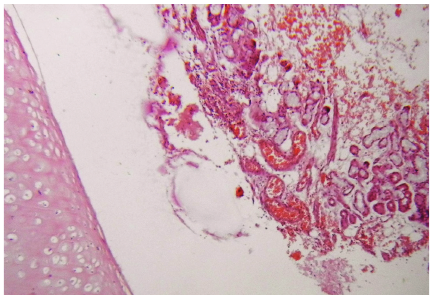
Figure 4: Section from the tumor showing cartilage tissue with salivary glands, H & E 10x objective.